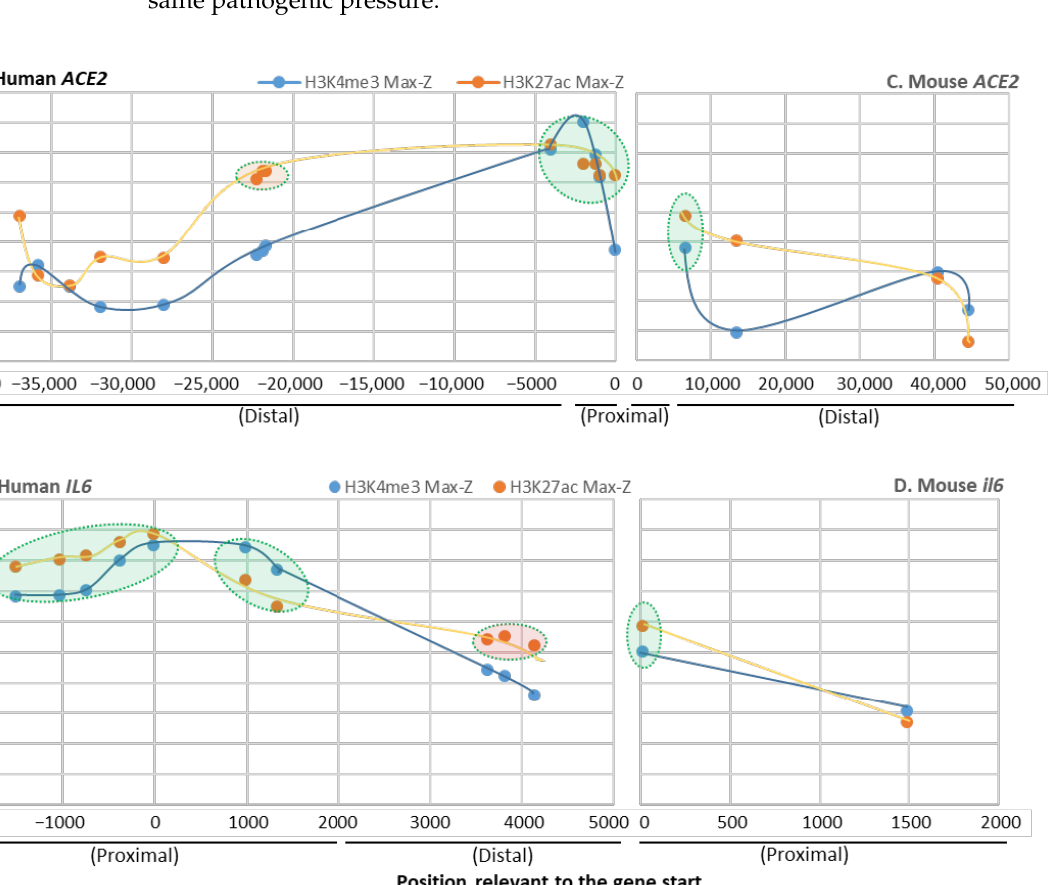
Figure 2. Profiling of positive histone markers (H3K4me3 and H3K27ac) indicating chromatin accessibility of RNA polymerase II adjacent to human and mouse ACE2 and IL-6 gene bodies, respectively. Annotation of ENCODE epigenetic datasets (Chip-Seq and ATAC-Seq from 839 and 157 cell/tissue types of humans and mice, respectively, from https://www.encodeproject.org/). Comparative existence of H3K4me3 and H3K27ac markers was detected between IL-6 and ACE2 gene promoters in either humans ( A , B ) and mice ( C , D ); however, higher Z-scores and enrichment of H3K4me3 and H3K27ac were found in human IL-6 and ACE2 genes ( A , B ) than their orthologs in mice ( C , D ). Distal, >2000 bp before the transcription start sites (TSS), and proximal promoter within 2000 bp before the TSS. Datasets with Z-score higher than the overall average are shaded with oval shapes.